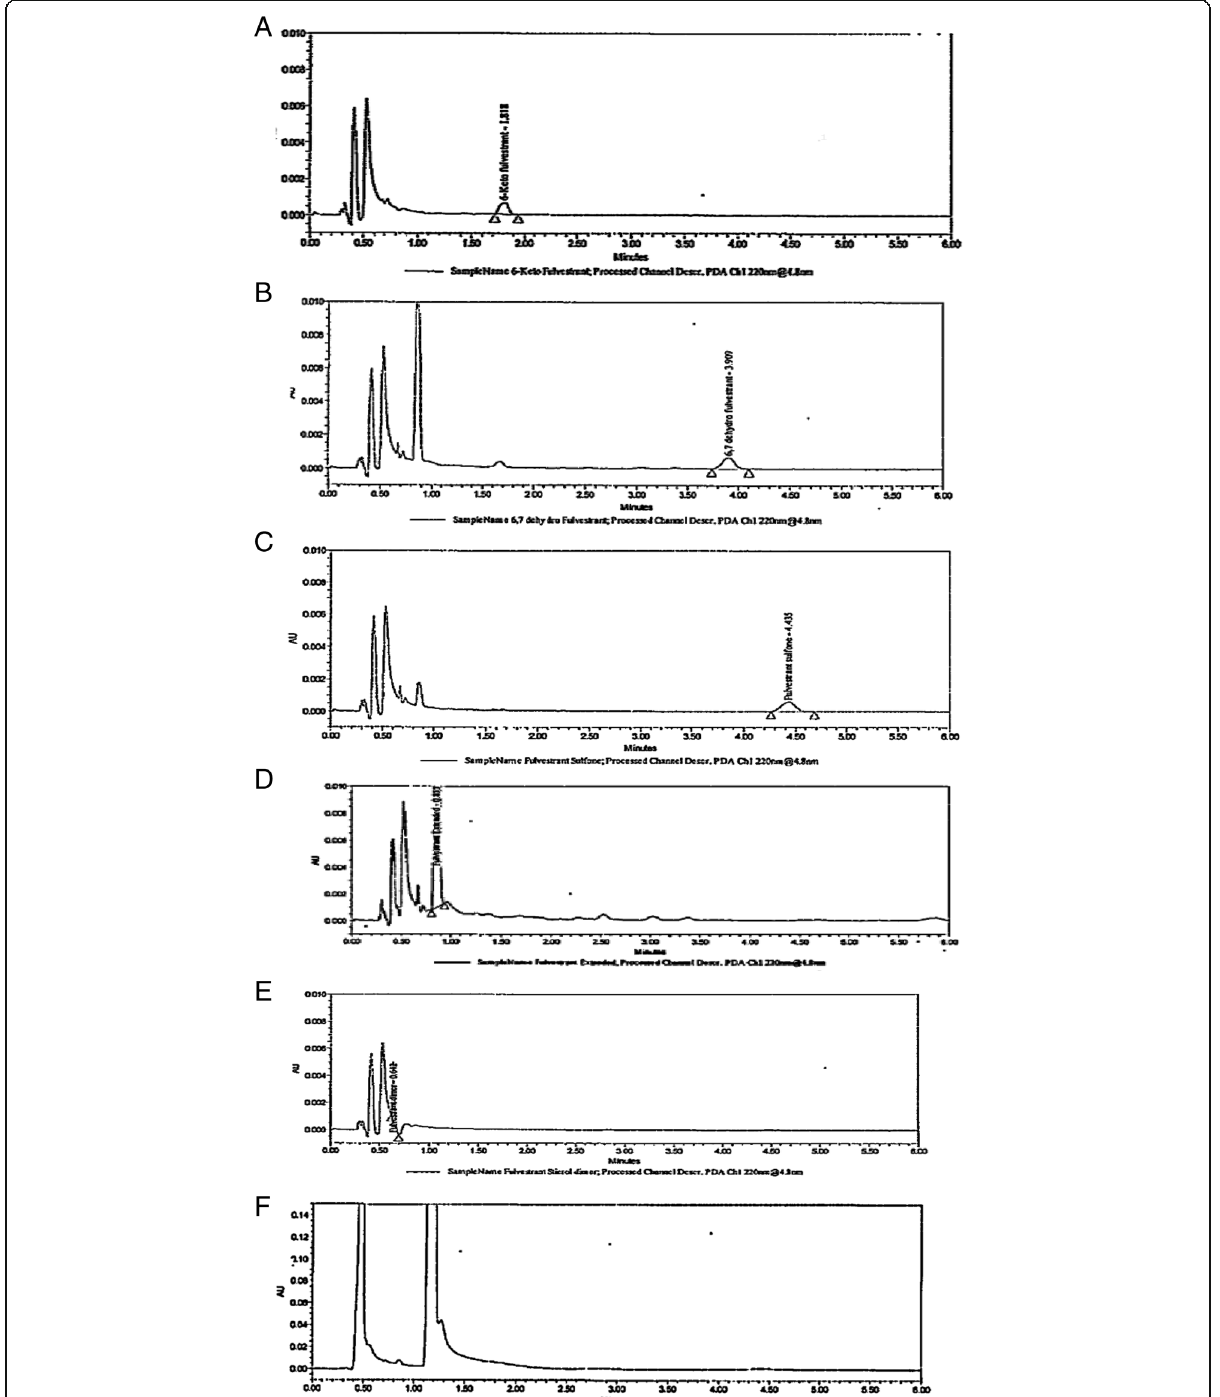
Fig. 4 a 6-Keto fulvestrant (1 μ g mL − 1 ). b Delta 6,7-fulvestrant (1 μ gmL − 1 ). c Fulvestrant 9-sulfone (1 μ gmL − 1 ). d Fulvestrant extended (1 μ gmL − 1